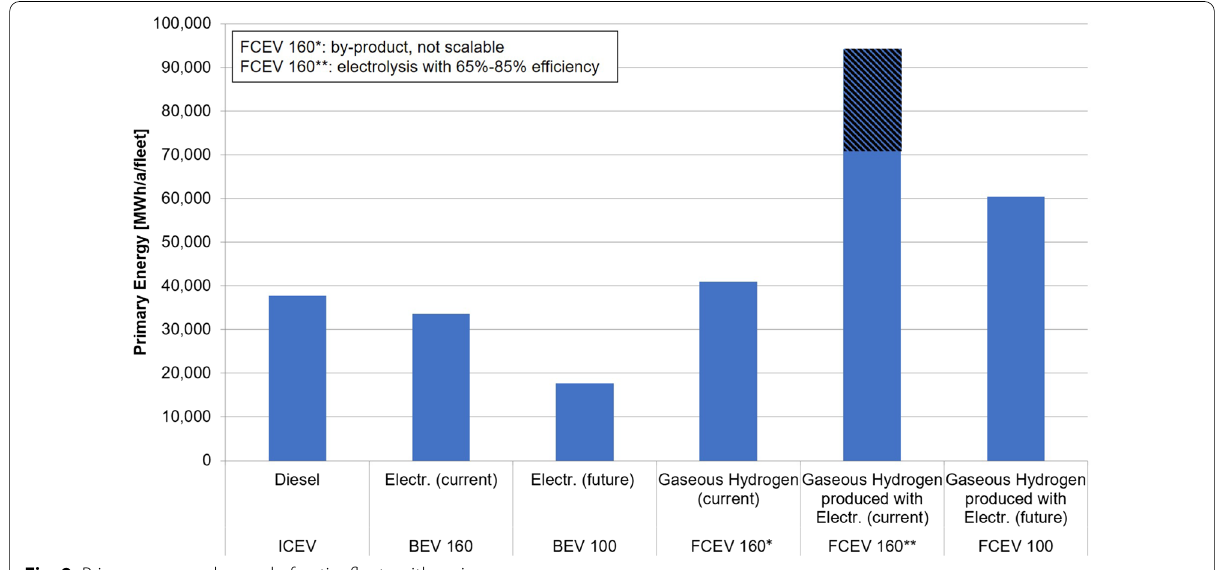
Fig. 9 Primary energy demand of entire fleets with various energy